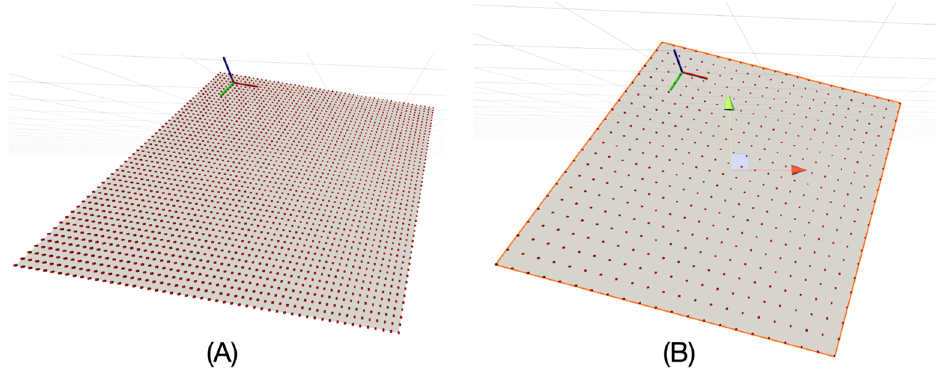
Figure 3. Plot of the reference surface in UnityMol showing the apparent vertices (red dots): ( A ) for a resolution of 4 Å; ( B ) for a resolution of 10Å.